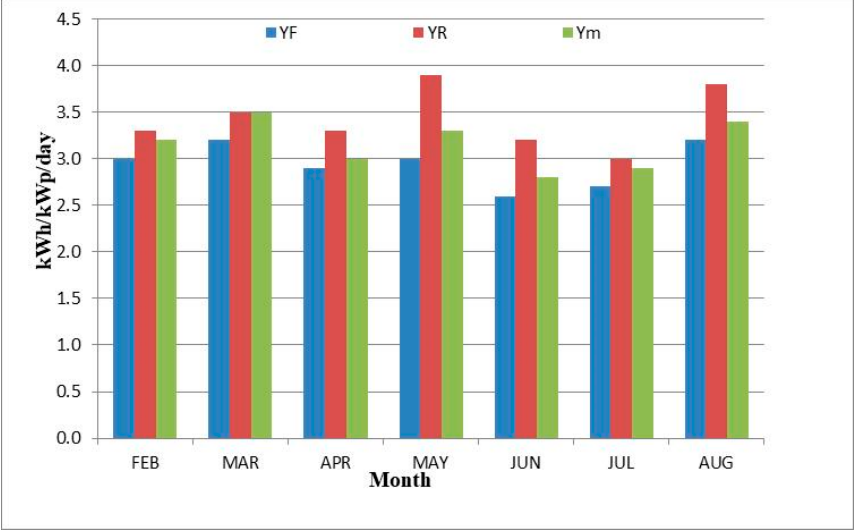
Figure 7. Monthly average daily yields.